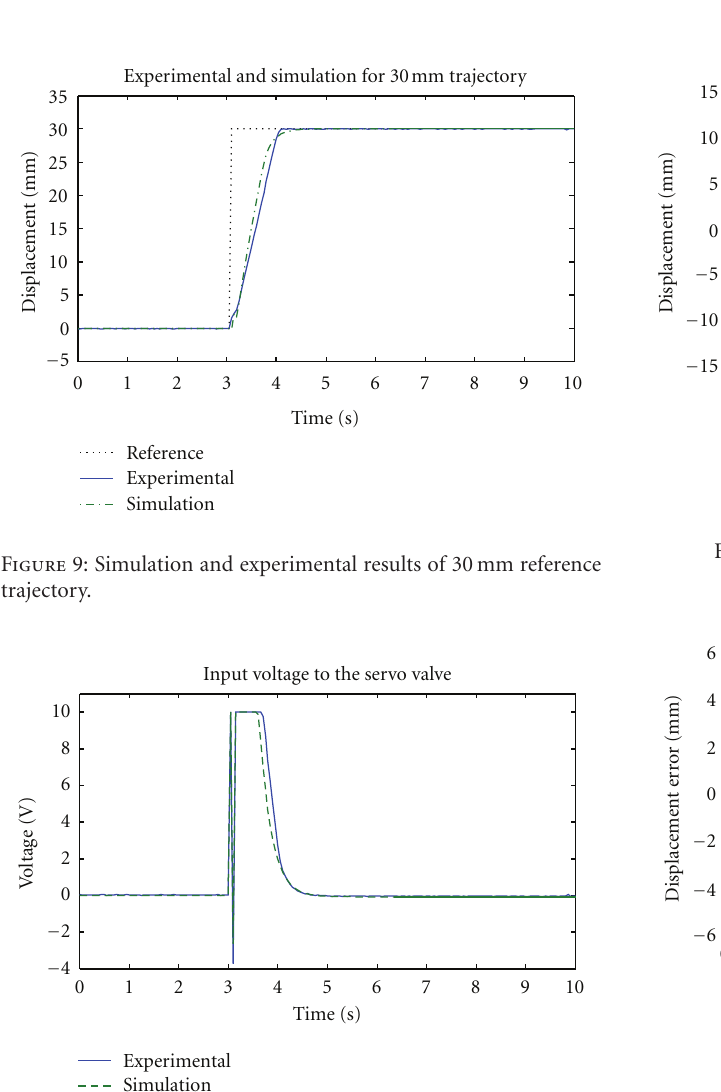
Figure 8: Proposed controller design.